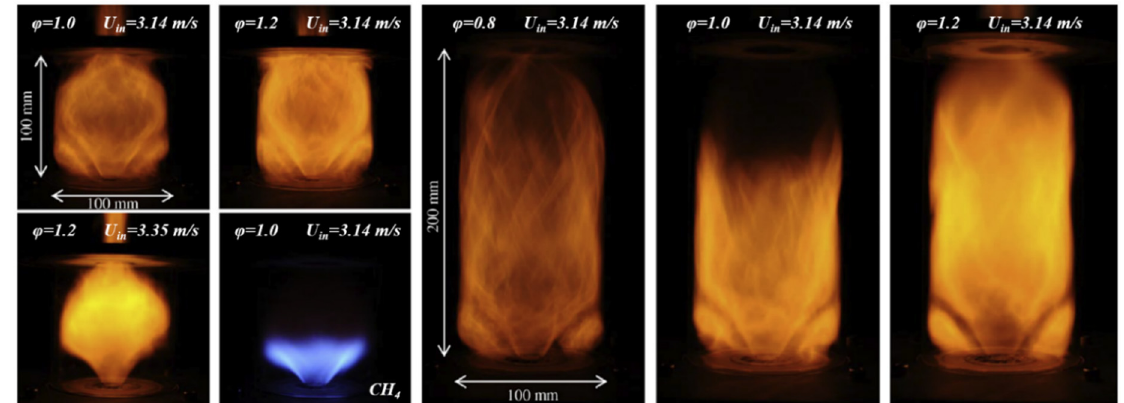
Figure 2. NH 3 -air and CH 4 -air flames stabilized in the swirl burner with cylindrical liners. Modified from [58]. Courtesy of Elsevier [58].